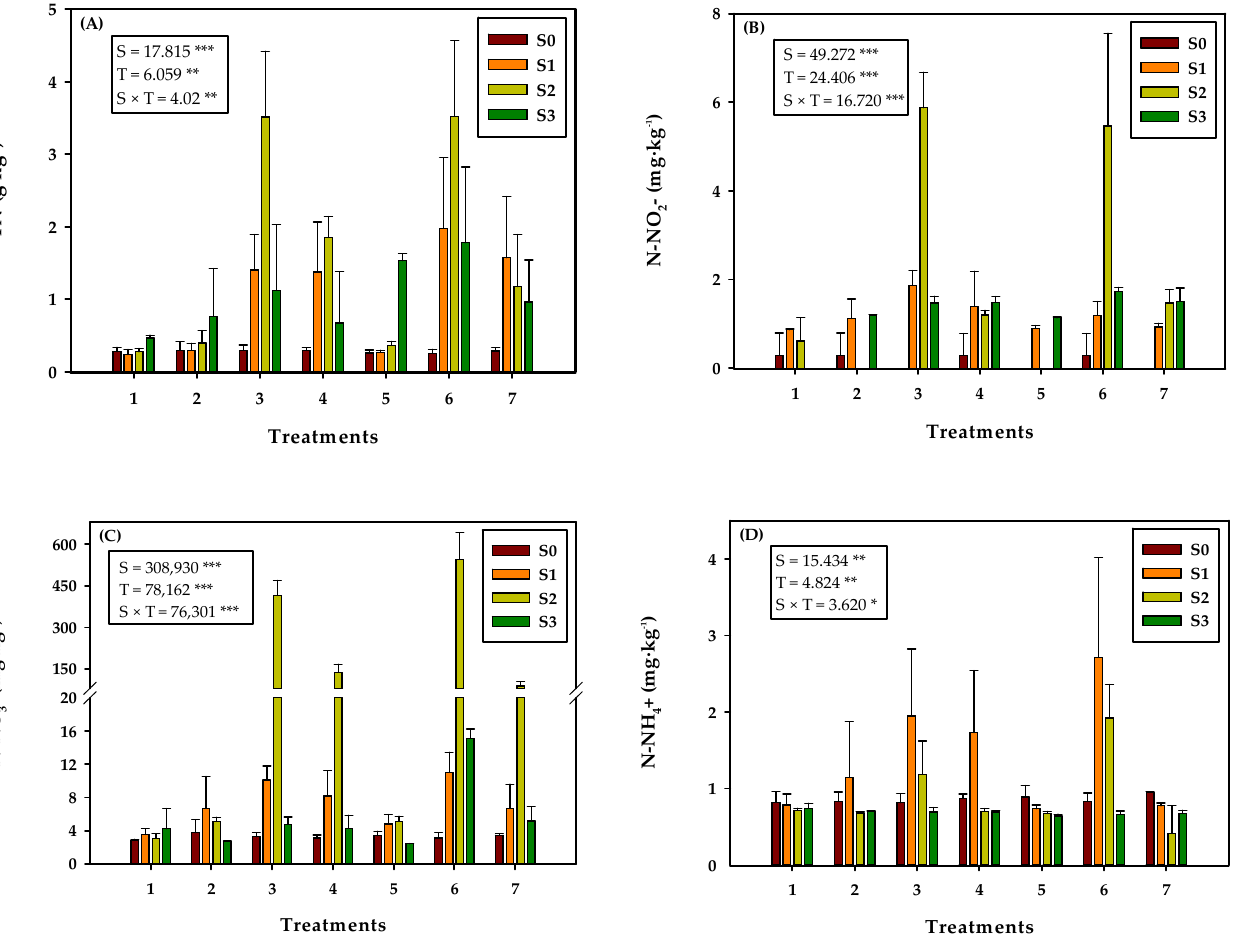
Figure 3. Mean concentration of TN ( A ), N-NO 2 − ( B ), N-NO 3 − ( C ) and N-NH 4+ ( D ) in the different treatments (1–7). 1: control; 2: limestone and biochar; 3: limestone and compost; 4: limestone, biochar and compost; 5: biochar, limestone and zeolite; 6: limestone, compost and zeolite; and 7: limestone, biochar, compost and zeolite. S0: sampling 0, S1 sampling 1, S2: sampling 2; and S3: sampling 3. Error bars denote standard deviation ( n = 3). F values and significance of the two-way repeated measures ANOVA are shown in each graph. S: sampling; T: treatment. Significant at * p < 0.05, ** p < 0.01 and *** p < 0.001; ns: not significant ( p > 0.05). ( A ) Mean concentration of TN in the different